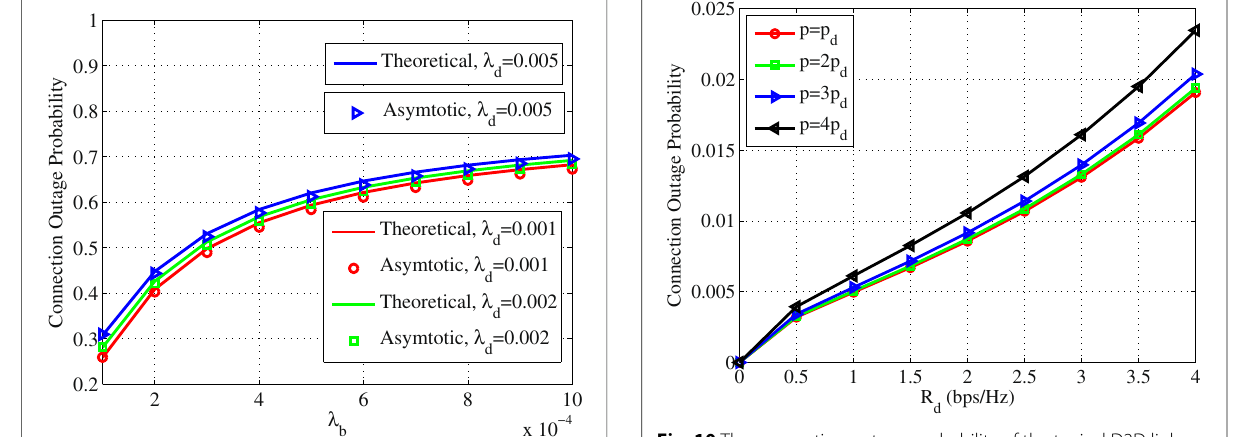
Fig. 10 The connection outage probability of the typical D2D link versus R d underdifferenttotaltransmissionpower p where p d = 10 dBm . Figure 10. describes comparison results of the connection outage probability of the typical D2D link under different total transmission power of each base